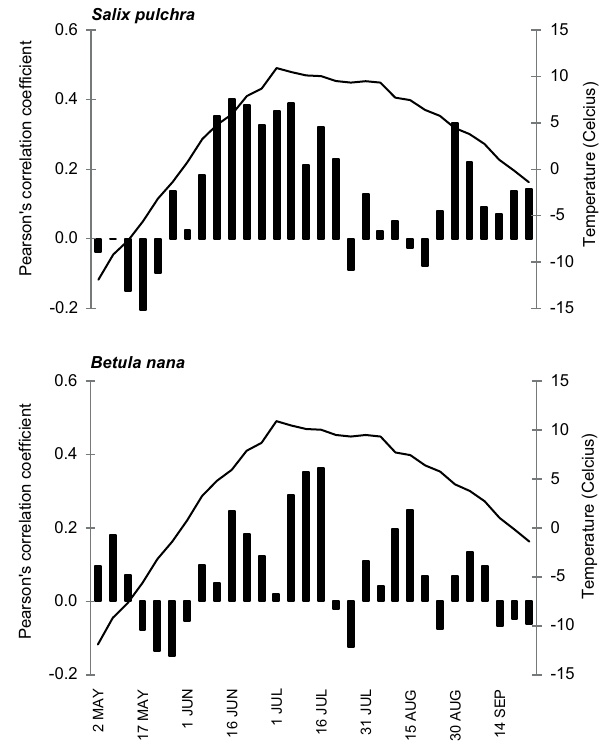
Fig. 1. The vertical bars show Pearson’s correlation coefficients between the mean average temperature of 5-day periods (pentads) measured at the Chokurdakh meteorological station for the period 1948–2006, and the residual chronologies of Salix pulchra and Betula nana . The continuous line shows average daily temperature data for the period 1948–2006 from the meteorological station in